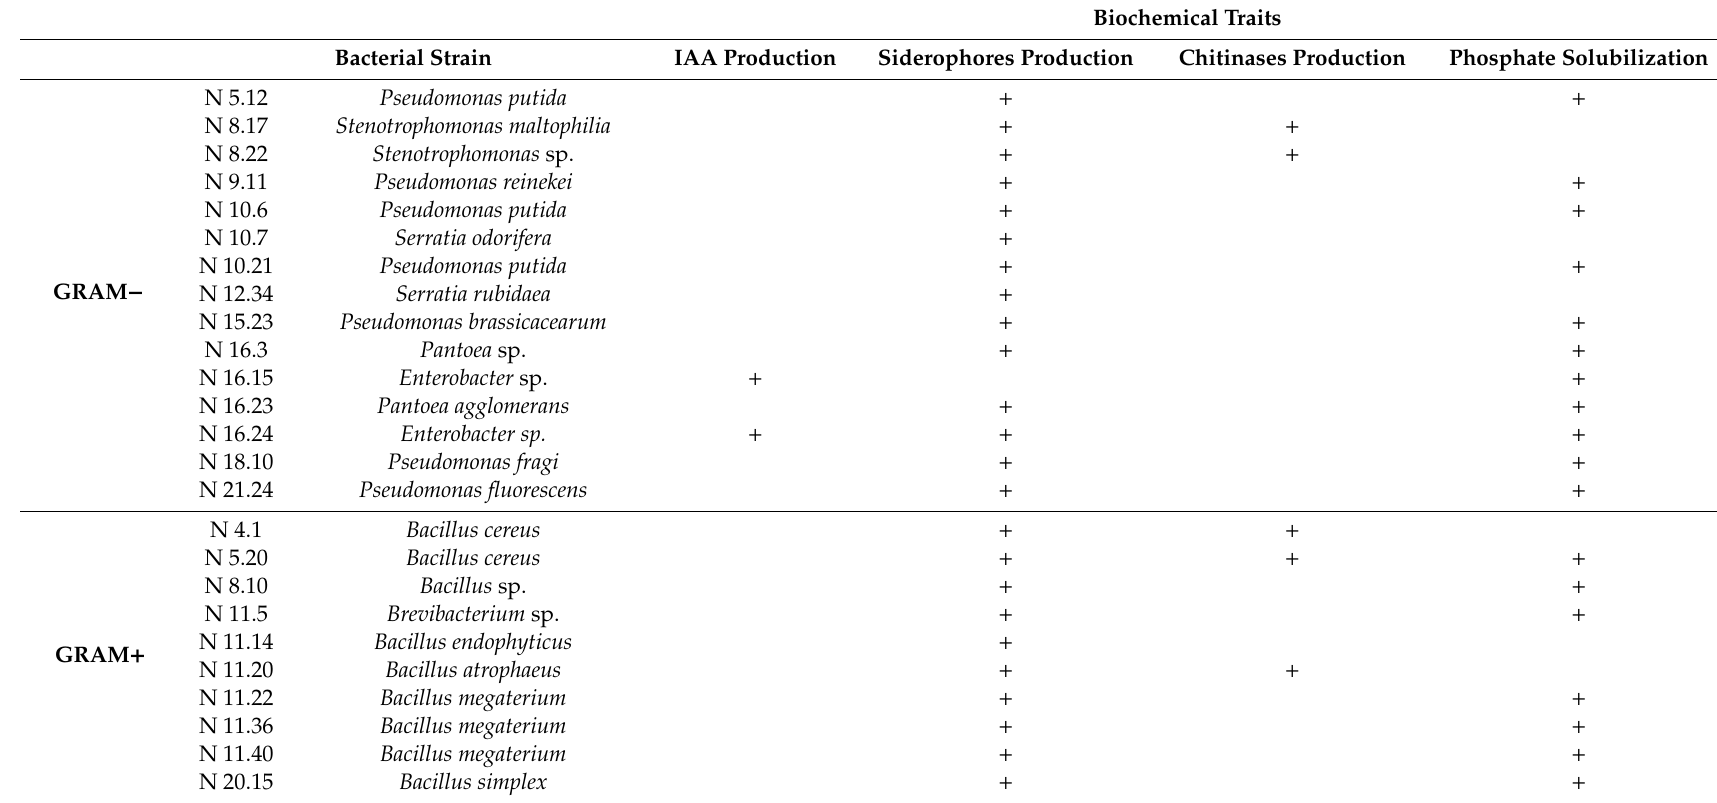
Table 2. Twenty-five selected strains and its biochemical